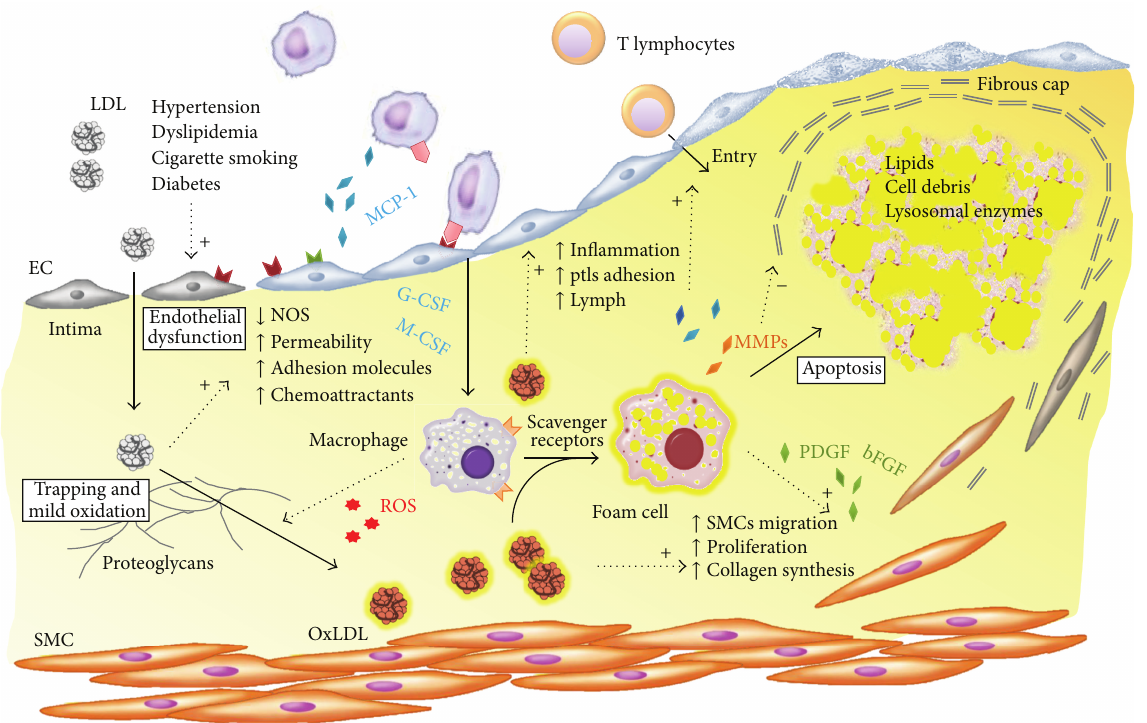
Figure 1: Putative pathway of oxidized low-density lipoprotein (oxLDL) in the atherogenetic process according to the oxidative hypothesis of